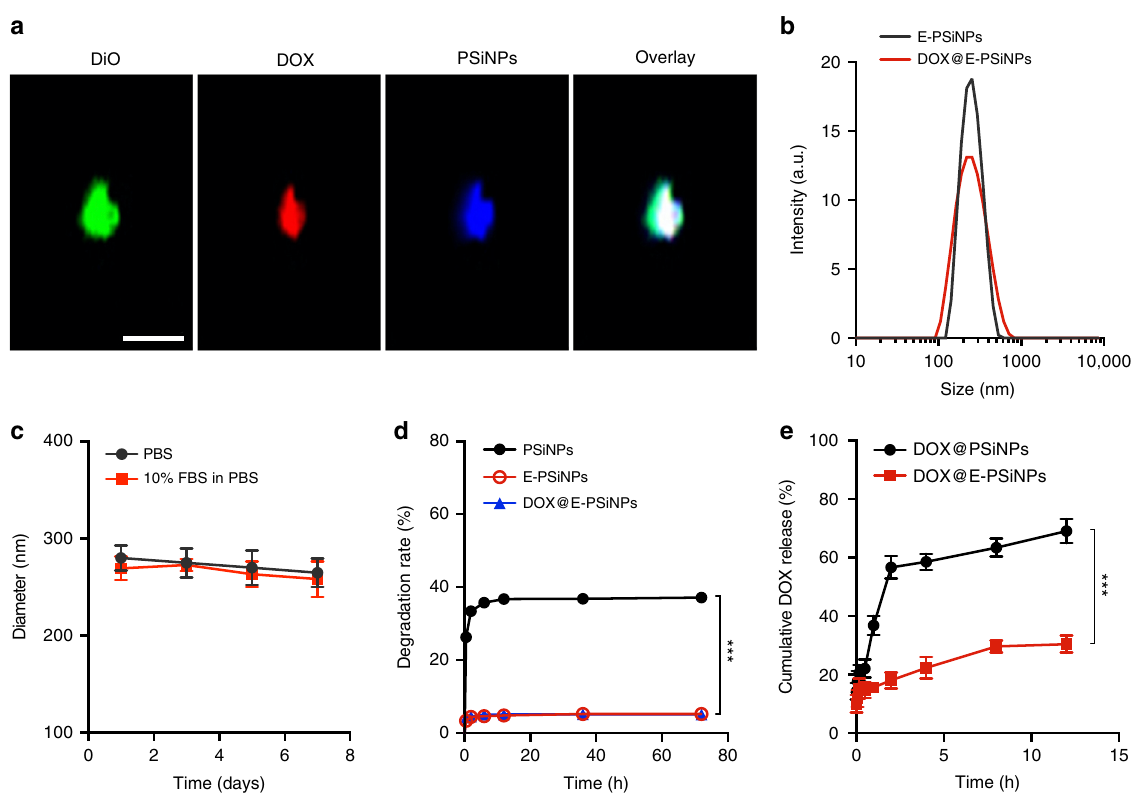
Fig. 4 Characterization of DOX@E-PSiNPs. a Colocalization of DiO, DOX, and PSiNPs in DOX@E-PSiNPs exocytosed from Bel7402 cells by confocal microscopy. Scale bar: 1 µ m. b Hydrodynamic diameter of E-PSiNPs and DOX@E-PSiNPs by DLS. c Hydrodynamic diameter of E-PSiNPs incubating in PBS with or without 10% FBS for different time intervals. d Degradation behavior of PSiNPs, E-PSiNPs and DOX@E-PSiNPs in PBS at 37 °C. e In vitro DOX release pro fi les of DOX@PSiNPs and DOX@E-PSiNPs in PBS at pH 7.4 by dialysis bag. Data were presented as mean ± SD ( n = 3). *** P < 0.001 (one-way ANOVA with Bonferroni ’ s multiple comparisons test for d and unpaired two-tailed Student ’ s t test for e ). Source data are provided as a Source Data fi